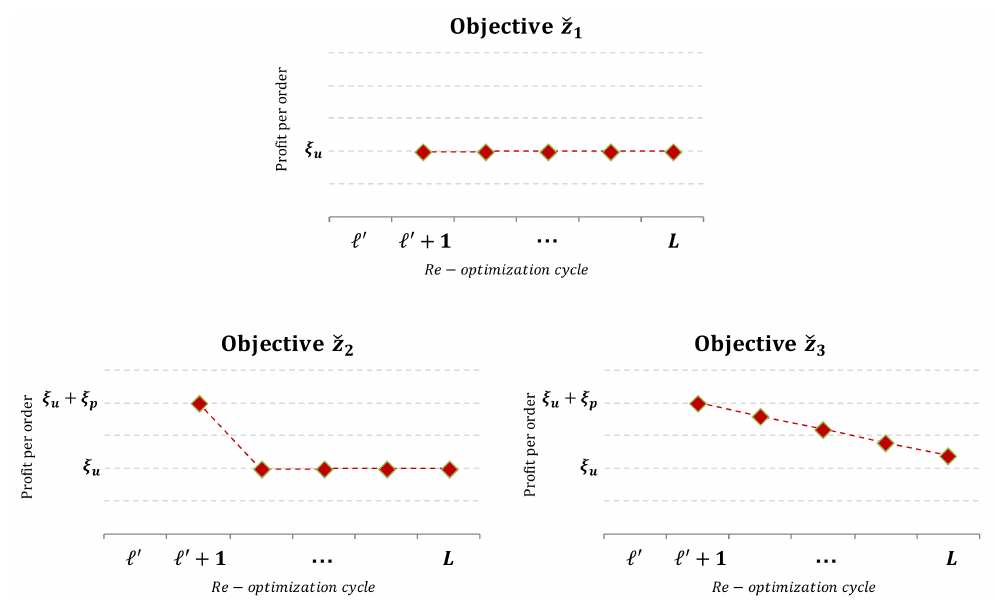
Figure 2. Profit per order for the three